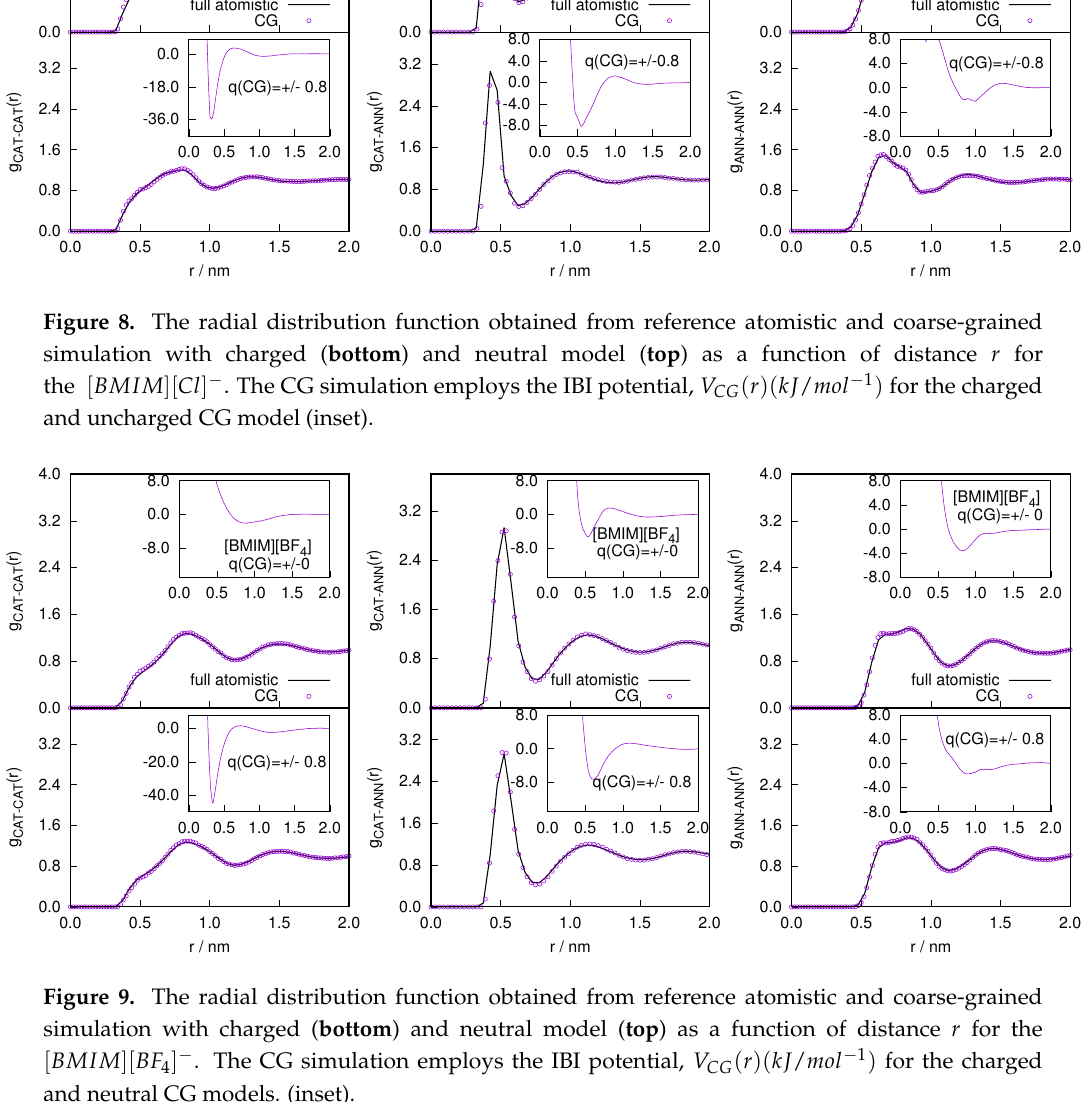
( r )( kJ / mol − 1 ) for the charged CG